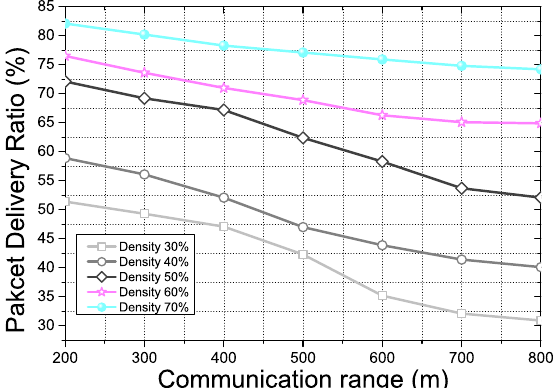
Figure 11. PDR for AP density and communication